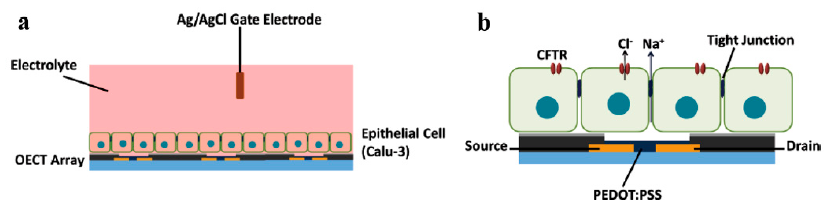
Figure 15. Human airway epithelial Calu-3 cells on top of an OECT array. ( a ) Architecture of the device. Cells form a dense monolayer on top of the surface, in-between the OECTs and the electrolyte; ( b ) detail showing the ion exchange occurring through the cell monolayer. Reproduced from Yao et al. [83]. Copyright © 2013, John Wiley and Sons.